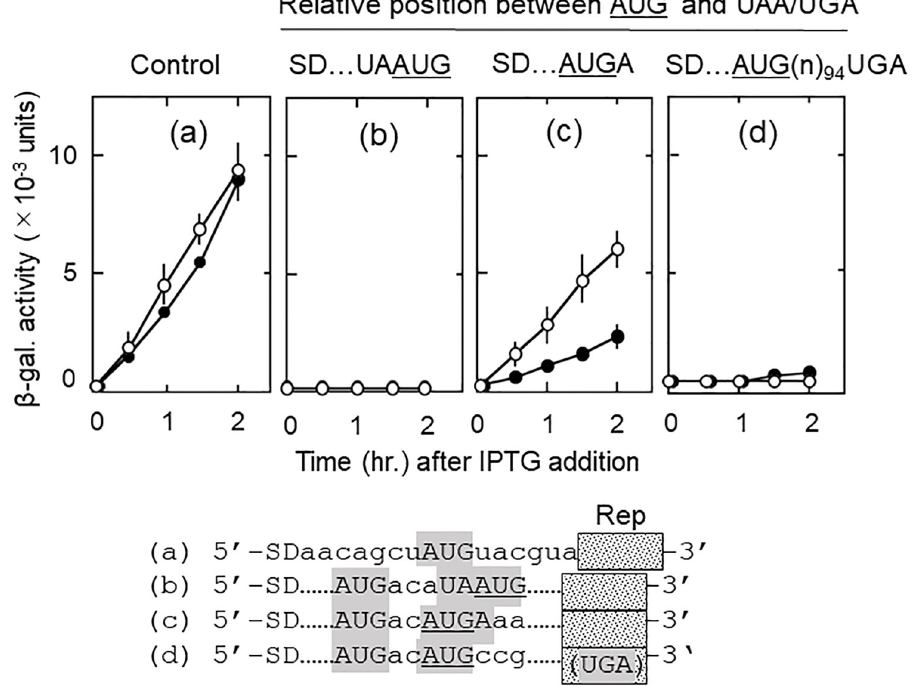
Fig 7. The relative positions of the initiation and termination codons in relation to the position of SD influences the d-ORF reading. Numbers of codons in u-ORF are shown above each panel. SD represents the SD sequence (5’- AGGA-3’). UAA and UGA are the termination codons of u-ORF. AUG is the initiation codon of d-ORF and in frame with the reporter lacZ ( Δ 27) gene. Dotted lines ( ...... ) represent the same nucleotide sequences with that of the plasmid of panel (a) in the corresponding regions. Panel (a) has no junction sequence representing the u-ORF reading. In panel (b), AUG is downstream of UAA. In (c), AUG is upstream of UGA. In (d), termination codon UGA of u-ORF is 94 nucleotides far from AUG and exists within the reporter